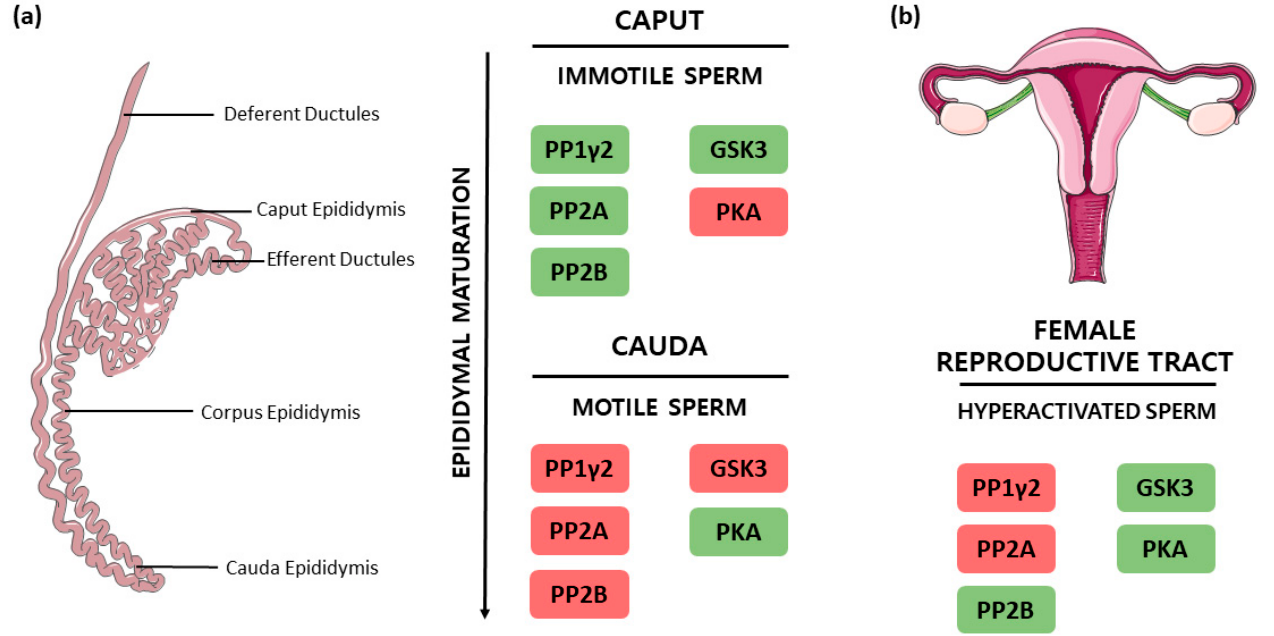
Figure 1. Representation of the PPs and PKs involved in activated motility acquisition in the epididymis, as well as in hyperactivation in the female reproductive tract. The colour green represents catalytic activity, whereas red stands for enzymatic inactivity. ( a ) Epididymis representation including its three epididymal subdivisions: caput, corpus, and cauda, as well as deferent and efferent ducts. In caput epididymis spermatozoa are immotile, the PPs PP1 γ 2, PP2A, PP2B and the PK GSK3 present catalytic activity, while PKA is inactive. In cauda, mature and progressively motile sperm are characterized by inactive PP1 γ 2, PP2A, PP2B and GSK3 and active PKA. ( b ) Feminine reproductive tract representation where hyperactivated spermatozoa presents inactive PP1 γ 2 and PP2A, whereas PP2B, GSK3 and PKA present catalytic activity.